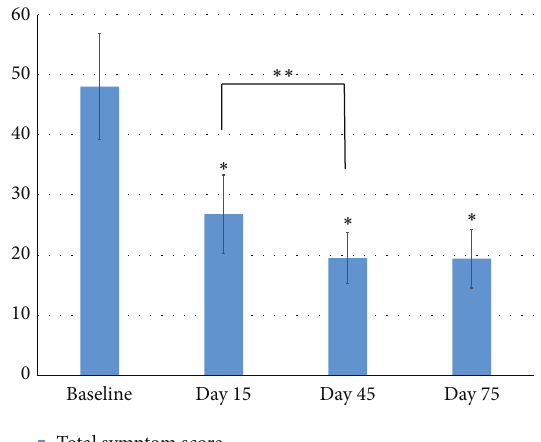
Figure 1: Total symptom scores. Notes: the total scores of the 10 single symptoms were defined as the total symptom scores. ∗ Compared to the baseline, the total symptom score significantly decreased at the time of D15, D45, and D75 ( 𝑃 < 0.01 ). ∗∗ Between the visits of D15 and D45, the total score continuously decreased ( 𝑃 = 0.04 ), while between the visits of D45 and D75, no significant difference was observed ( 𝑃 = 1 ). Statistical analysis was performed with paired 𝑡 -test with the Bonferroni